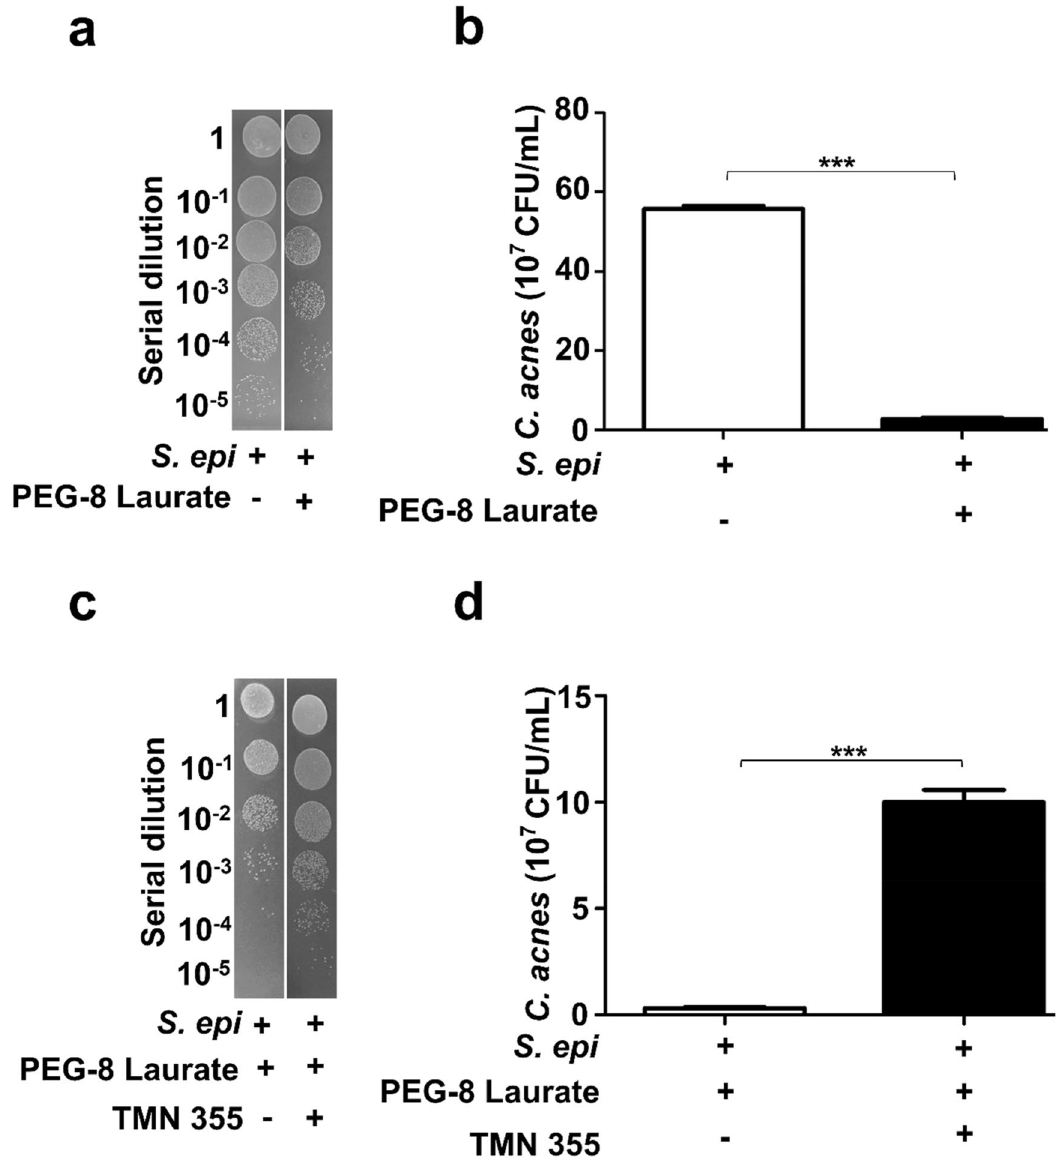
Figure 4. Cyclophilin A is an essential component for the interference of electrogenic S. epidermidis with C. acnes in vivo. ( a ) The number of C. acnes in ears of ICR mice after co-injection of C. acnes (10 7 CFU) and S. epidermidis ( S. epi ) (10 7 CFU) in the presence or absence of 2% PEG-8 Laurate was quantified after 72 h. ( b ) The number of C. acnes in ears of ICR mice after co-injection of C. acnes and S. epidermidis pretreated with/ without TMN 355 in the presence of 2% PEG-8 Laurate was calculated after 72 h. The CFUs of C. acnes in mouse ears were enumerated by plating serial dilutions (1 : 10 0 −1 : 10 5 ) of the ear homogenate on furazolidone - supplemented agar plates. Data are represented as mean ± SD, in triplicate from five mice per group. *** P < 0.001 (two-tailed